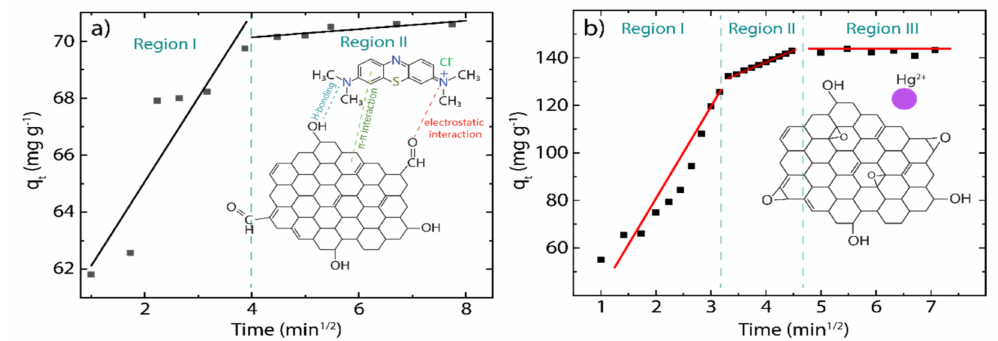
Figure 6. Intraparticle diffusion (IPD) study of ( a ) rGO+Mb and ( b ) rGO+Hg(II) at 298 K, showing different regions of linearity (MB concentration 100 mg L − 1 and Hg(II) concentration 150 mg L − 1